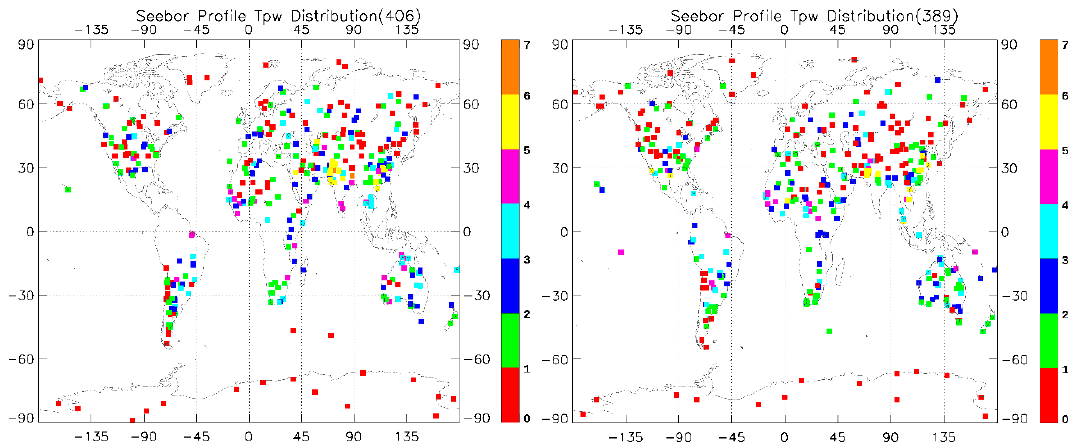
Figure 2. Selected profiles global distribution for daytime and nighttime. Colors represent the total column precipitable water (TPW) value (gcm –2 ).